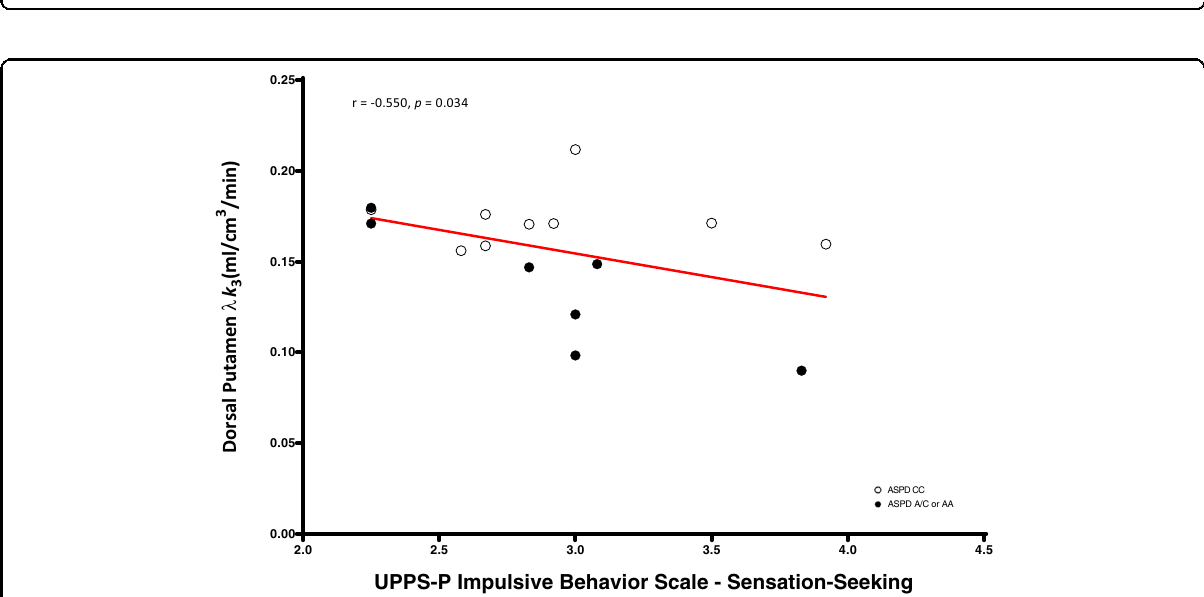
Fig. 3 Dorsal caudate fatty acid amide hydrolase λ k 3 is negatively correlated with UPPS-P Impulsive Behavior Scale — sensation-seeking in antisocial personality disorder. After controlling for genotype, antisocial personality disorder participants with lower dorsal caudate fatty acid amide hydrolase density endorsed greater sensation-seeking impulsivity.